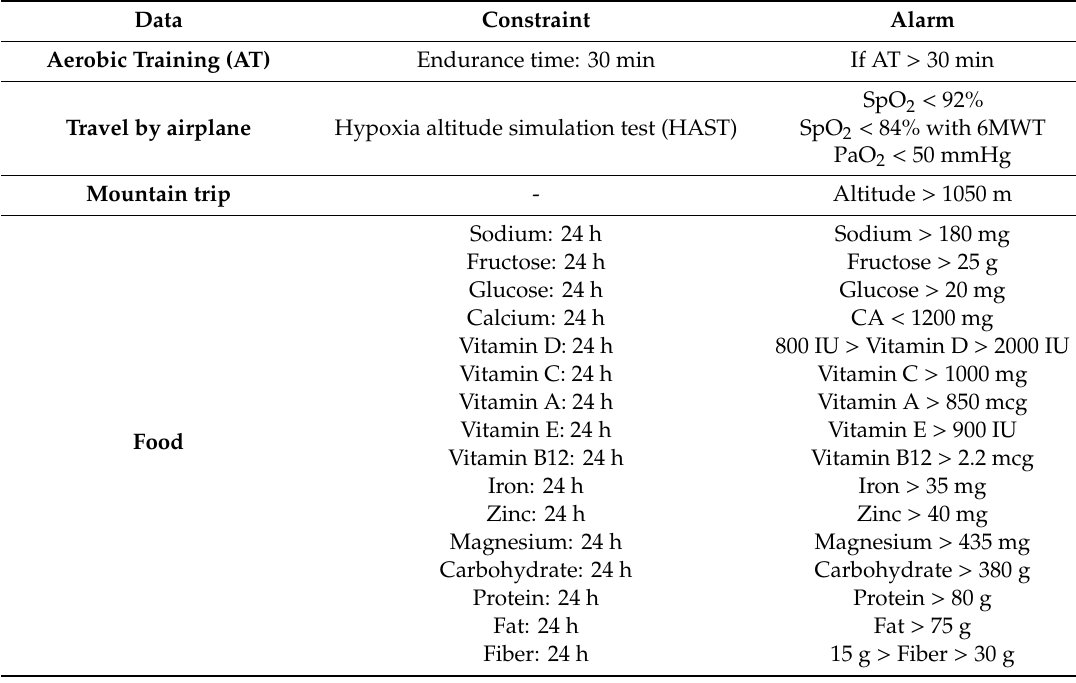
Table 11. Activities alarms and constraints for a specific profile.